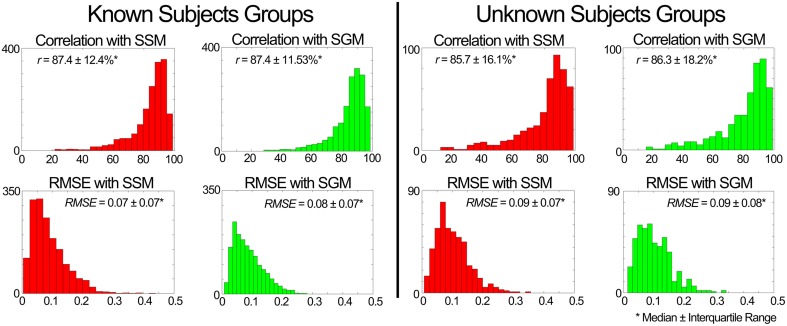
Performance of the muscle excitation profiles (MEP) predictor block developed in scenario 1. The plots depict histograms of the average (median ± interquartile range) correlation coefficient (r) and root mean square error (RMSE) between the estimated and experimental MEPs.